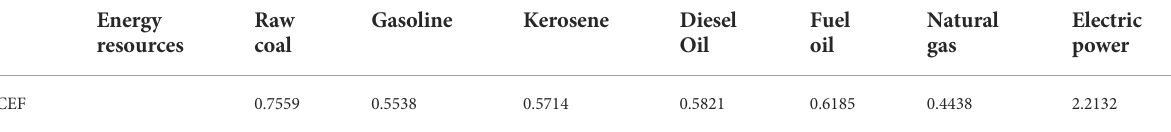
TABLE 1 Carbon emissions factors of various energy resources.